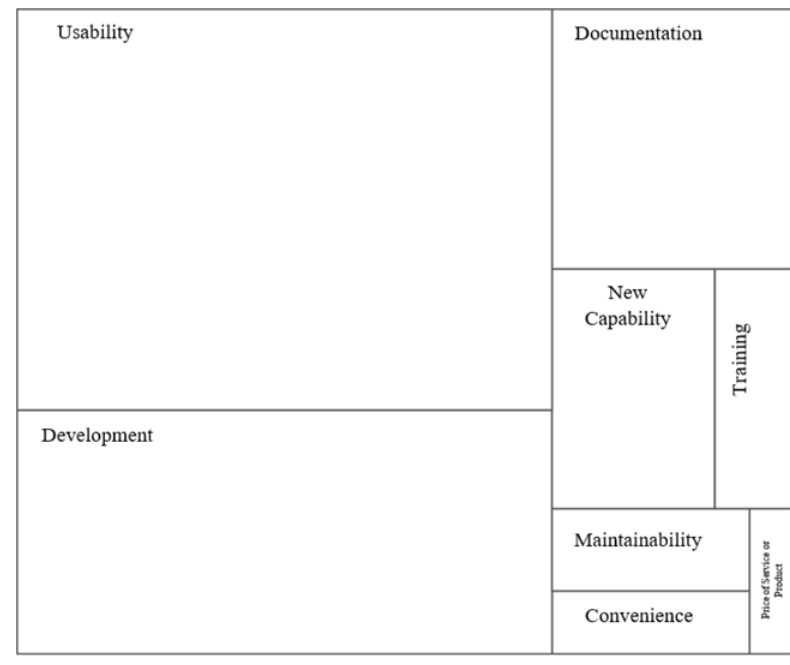
Figure 6 Level of Responses: Identified Success